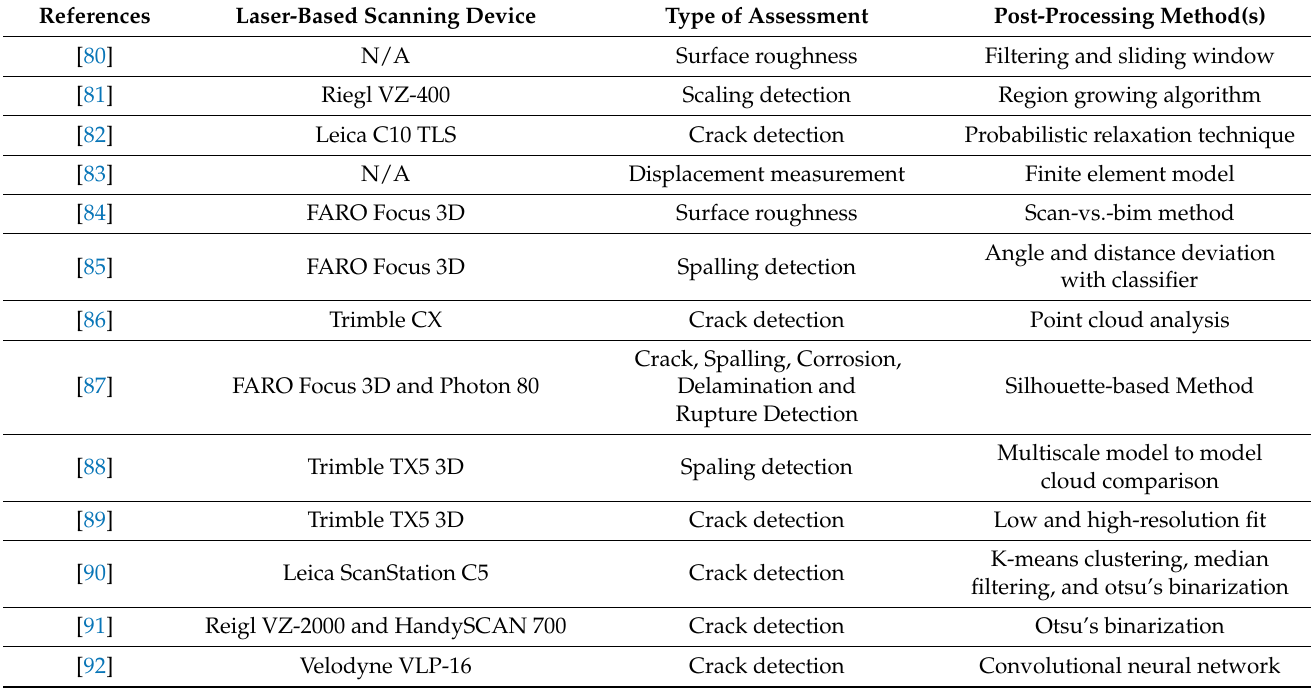
Table 6. A comprehensive summary of laser-based assessment techniques for concrete